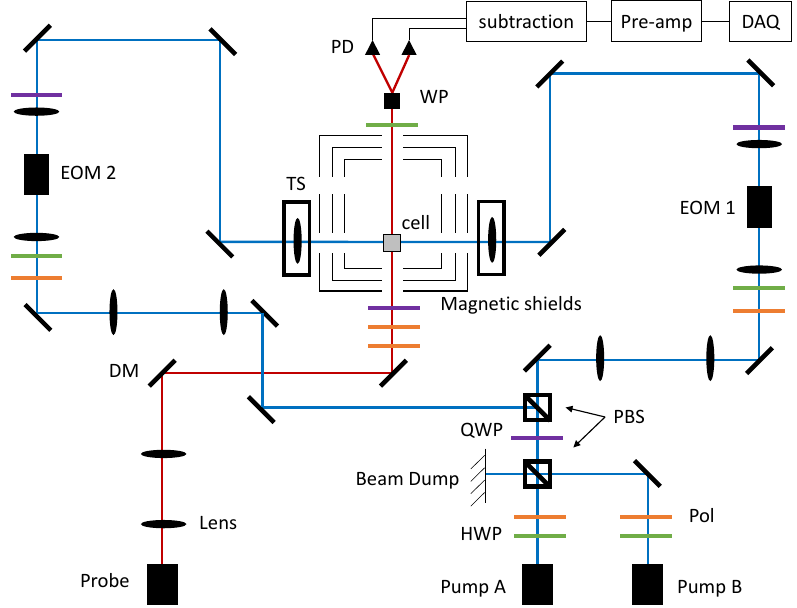
Figure 2. Experimental setup for PM excitation (not to scale). DM: dichroic mirror, Pol: polarizer, HWP: half wave plate, QWP: quarter wave plate, PBS: polarizing beam splitter, WP: Wollaston prism, PD: photodiode, EOM: electro-optic modulator, TS: two-axis translation stage with lens. The three-axis magnetic shim and pulsing coils are not shown. The setup fits on a four foot square optical